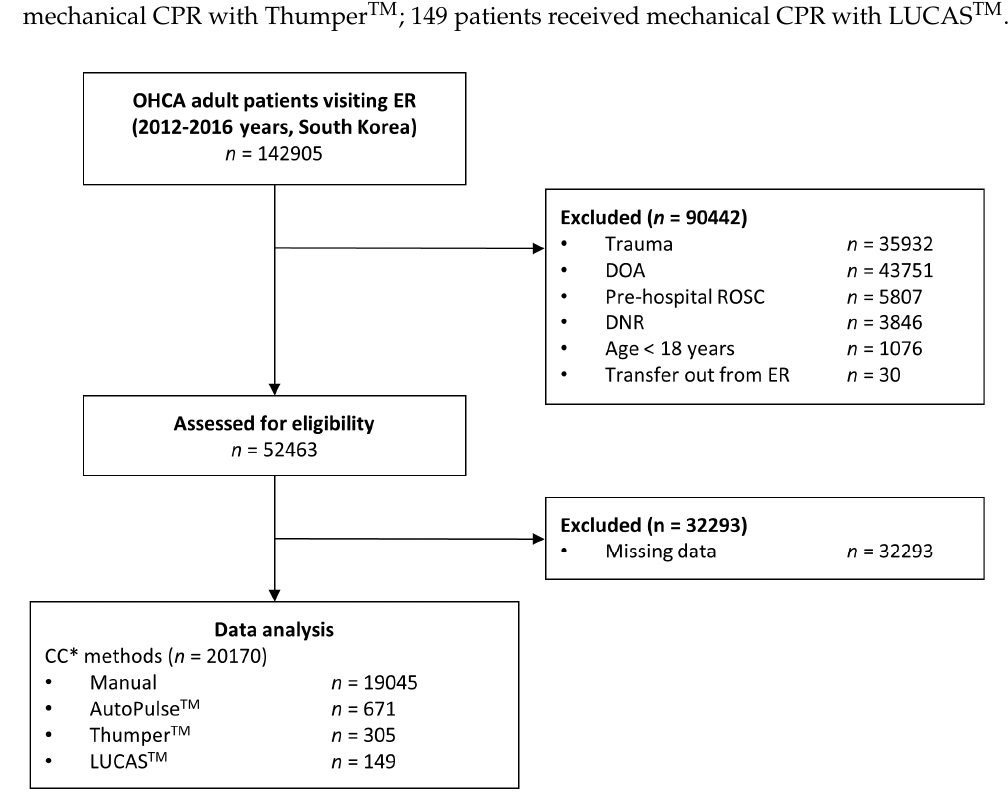
Figure 1. Flow diagram for the identification of relevant studies. A star (*) indicates chest compres- sion in emergency room. OHCA, out-of-hospital cardiac arrest; ER, emergency room; DOA, dead on arrival; ROSC, return of spontaneous circulation; DNR, do not resuscitate; and CC, chest com-